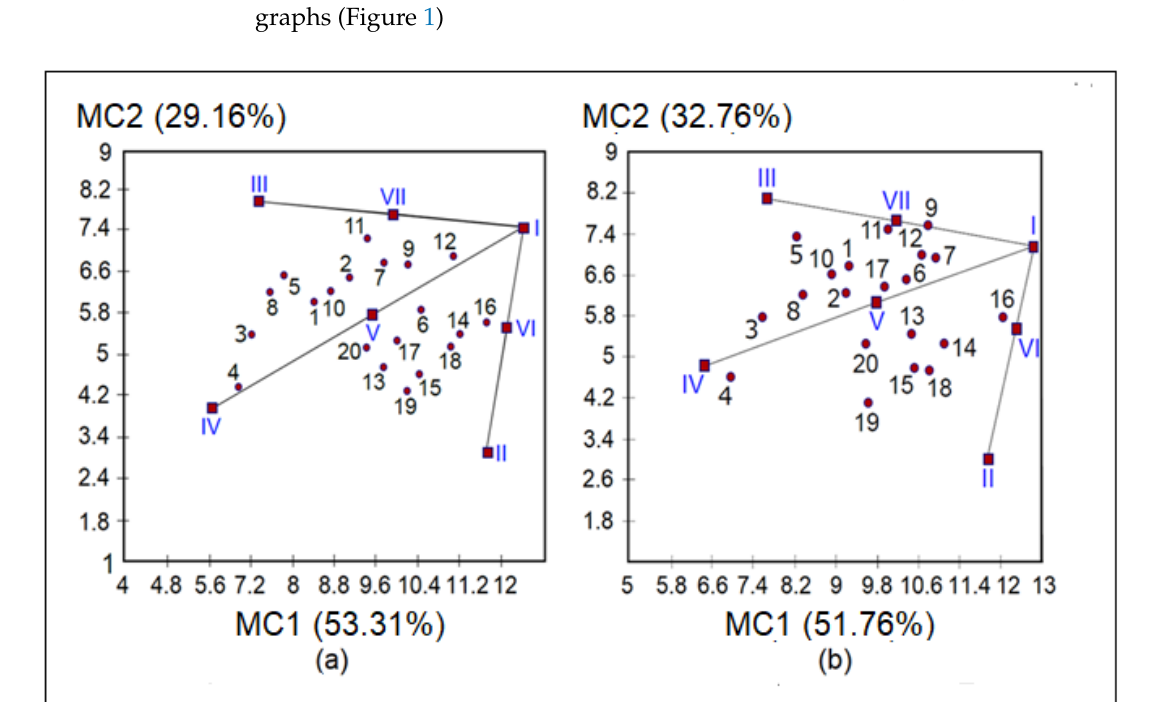
Table 7. Summary of the AMMI analysis of the traits tons of sucrose per hectare (TSH) and tons of fiber per hectare (TFH) in 20 sugarcane genotypes evaluated in five sugarcane microregions in the state of Pernambuco.